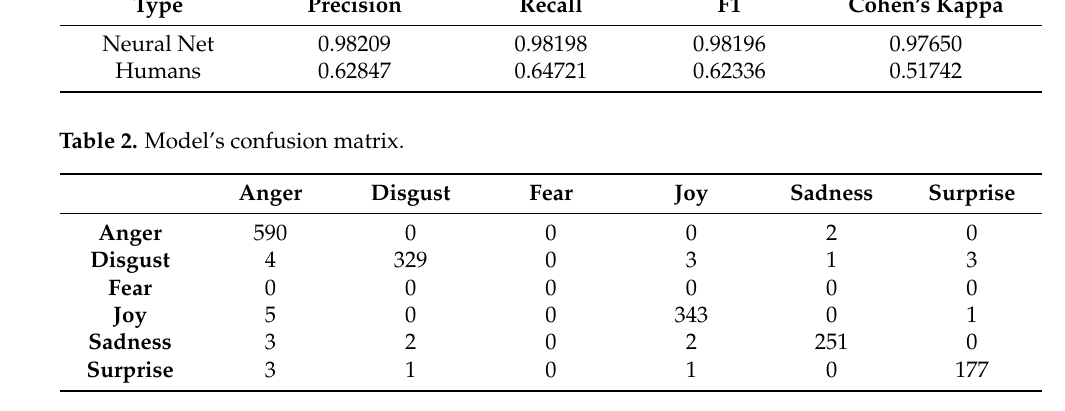
Table 1. Comparison of evaluations obtained by the neural network vs. human beings. Type Precision Recall F1